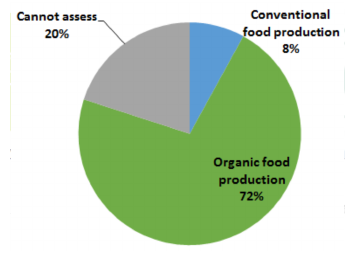
Figure 2. Perception of consumers on sustainable food production: in % of participants ( N =